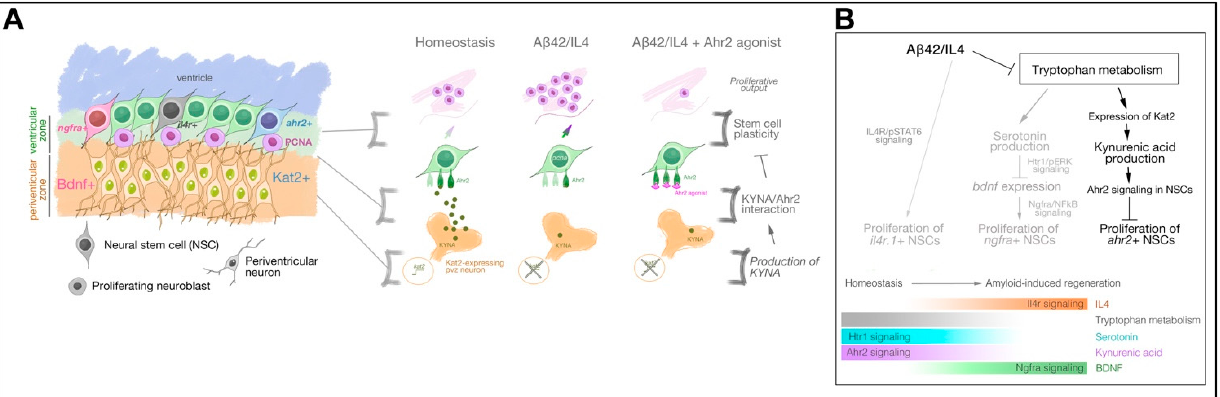
Figure 6. KYNA/Ahr2 signaling defines the third distinct Alzheimer’s disease-responsive subset of neural stem cell population in adult zebrafish brain ( A ) Schematic view of the regulation of neural stem cell plasticity and neurogenesis in adult zebrafish brain by KYNA/Ahr2 signaling. ( B ) Consolidated view of the effects of A β 42 on neural stem cell plasticity. A β 42 reduces the expression levels of KAT2, which generates KYNA, an inhibitory regulator of neural stem cell proliferation through its receptor Ahr2. For successful regeneration to take place, tryptophan metabolism is suppressed and IL4/BDNF ‐ mediated signaling mechanisms are enhanced.